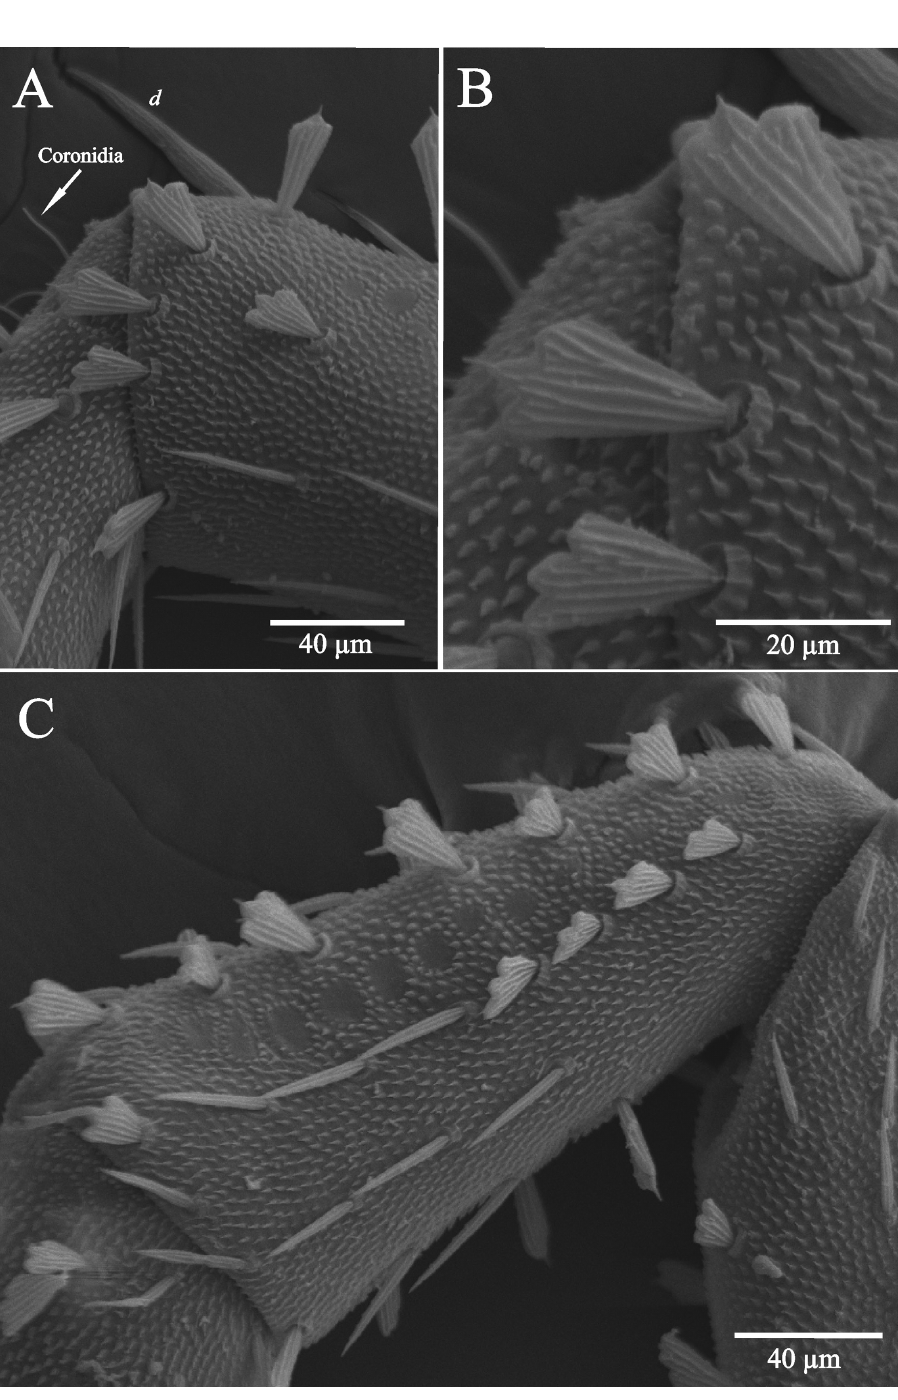
Figure 9. Neocarus spelaion sp. n.: A Lateral view of basitarsus and tibia, arrow indicating coronidia and mucronate setae ( d ) B Detail of the papiliform setae on tibia II; B lateral view of genu